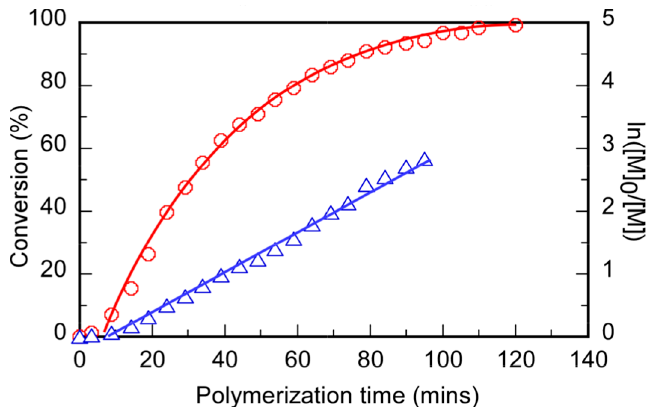
Figure 1. Time-conversion ( 〇 ) and the first-order kinetic plots ( △ ) for reversible addition-fragmentation chain-transfer (RAFT) copolymerization of cationic vinylbenzyl trimethylammonium chloride (VBTAC) and anionic sodium p -styrenesulfonate (NaSS) in a mixed solvent of methanol and D 2 O containing 1.2 M NaCl at 70 °C. Table 1. Monomer conversion ( p ), composition, degree of polymerization (DP), number-average molecular weight ( M n ), phase transition temperature ( T p ) for the polyampholytes